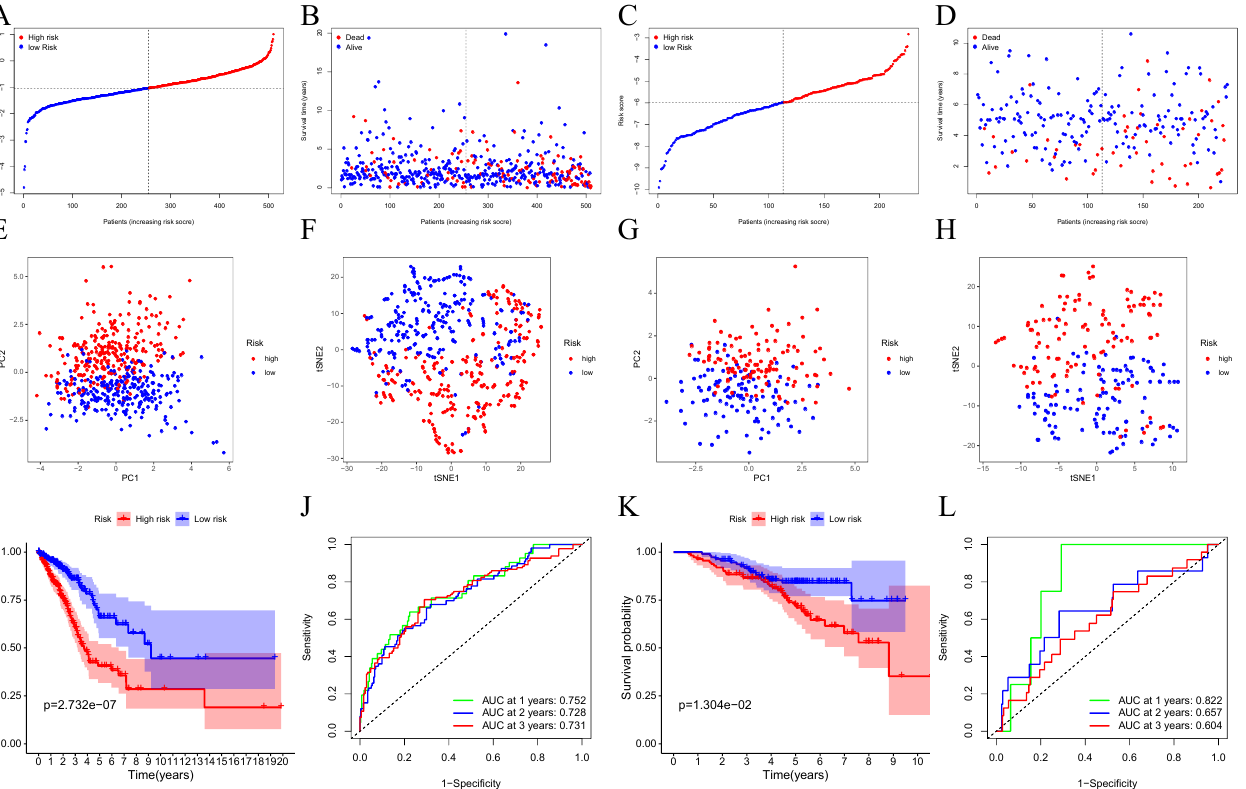
Figure 2. Validation of our 10-gene signature based on TCGA and GEO datasets. TCGA ( A , B , E , F , I , J ) and GEO ( C , D , G , H , K , L ) datasets. ( A , C ) Median risk scores. ( B , D ) OS distribution. ( E , G ) PCA plot. ( F , H ) t-SNE analysis. ( I , K ) K-M survival analysis of OS. ( J , L ) AUC value of t-ROC curves for